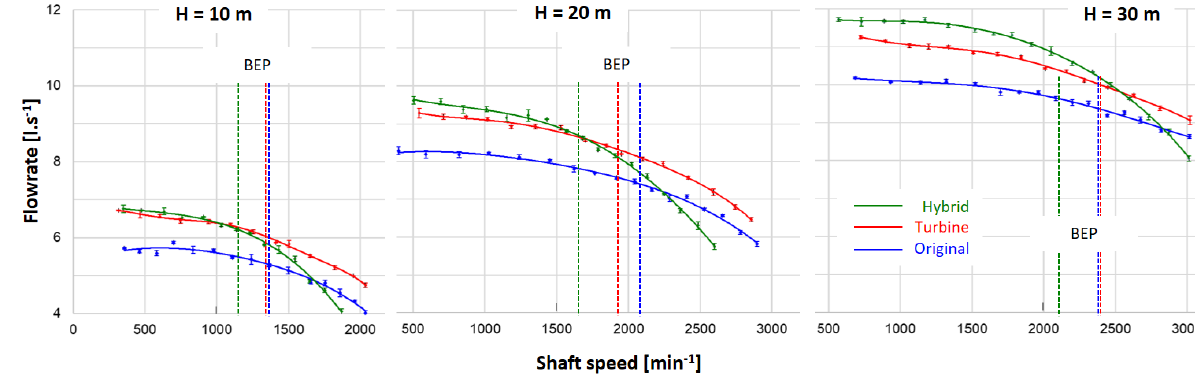
Figure 12. Courses of flow rate in terms of dependence on shaft speed. Table 3. ( a ) Overview of absolute values of performance parameters achieved at BEP at net head of 10 and 20 m. ( b ) Overview of absolute values of performance parameters achieved at BEP at net head of 30 m.